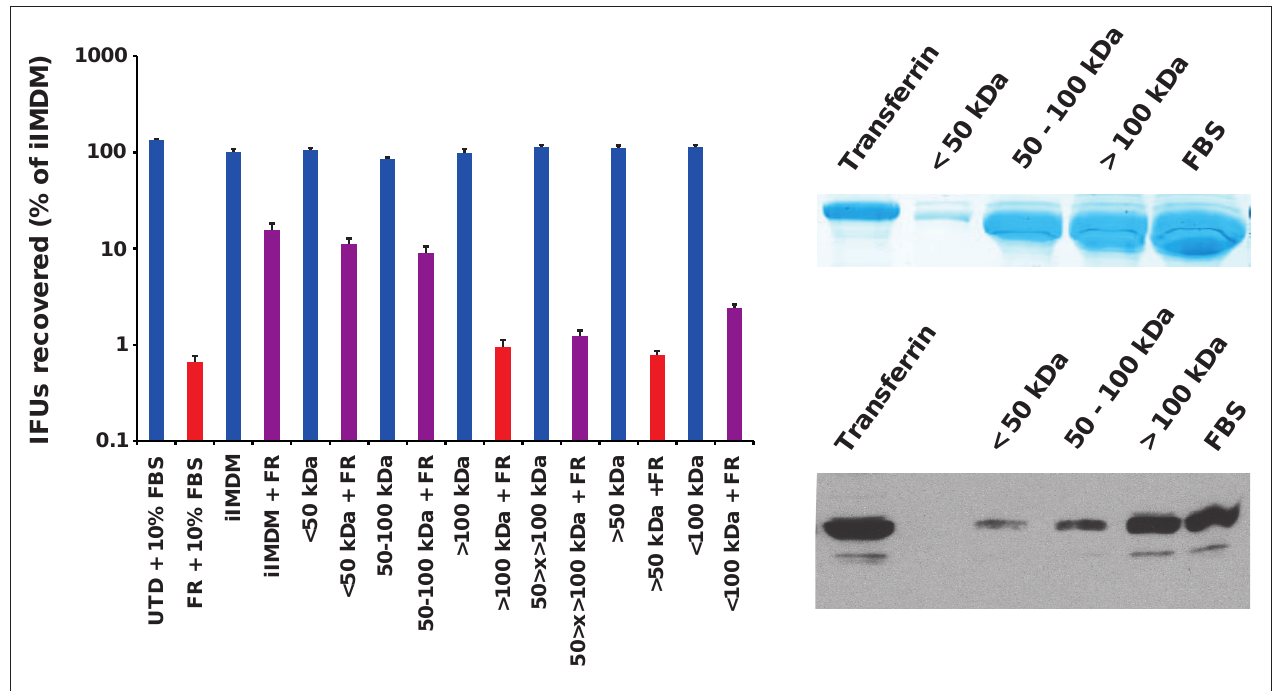
statistically significant difference compared to FR treatment, hence restoration of inhibition; whereas purple bars indicate a significant difference ( p < 0.05 by Student’s t -test). SDS-PAGE analysis and Western blot of serum fractions for Tf content compared to complete serum (FBS) and purified, commercially available Tf.